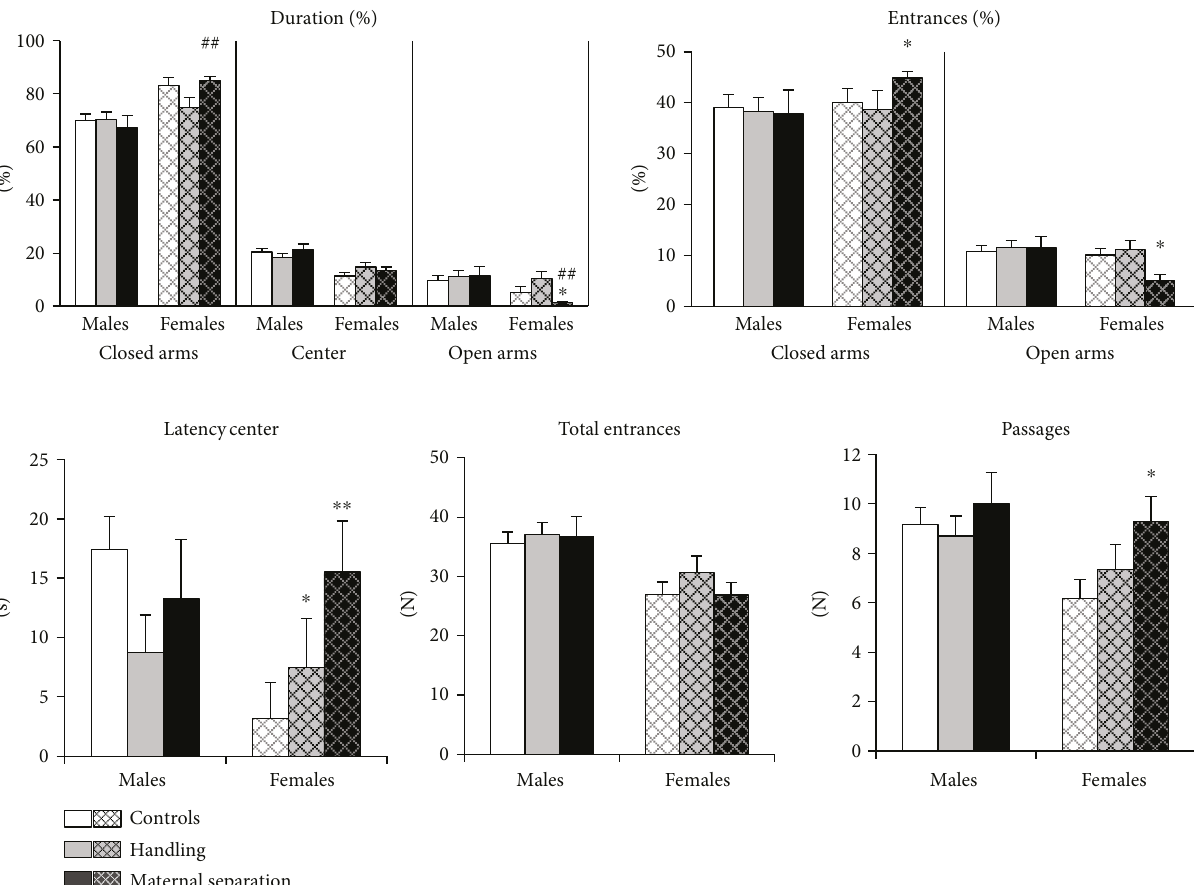
Figure 2: E ff ects of early-life stress on the behavior of adult mice in the plus-maze test. Early-life stress had no e ff ect on plus-maze behavior in male mice but led to signi fi cant anxiogenic e ff ect in MS females. Data present as mean ± standard error of the mean (SEM). White box: controls (males n = 11 , females n = 11 ); grey box: HD (males n = 10 , females n = 6 ), black box: MS (males n = 6 , females n = 8 ); open columns: males; cross-hatched columns: females. ∗ p < 0 05 , ∗∗ p < 0 01 compared to controls; ## p < 0 01 compared to